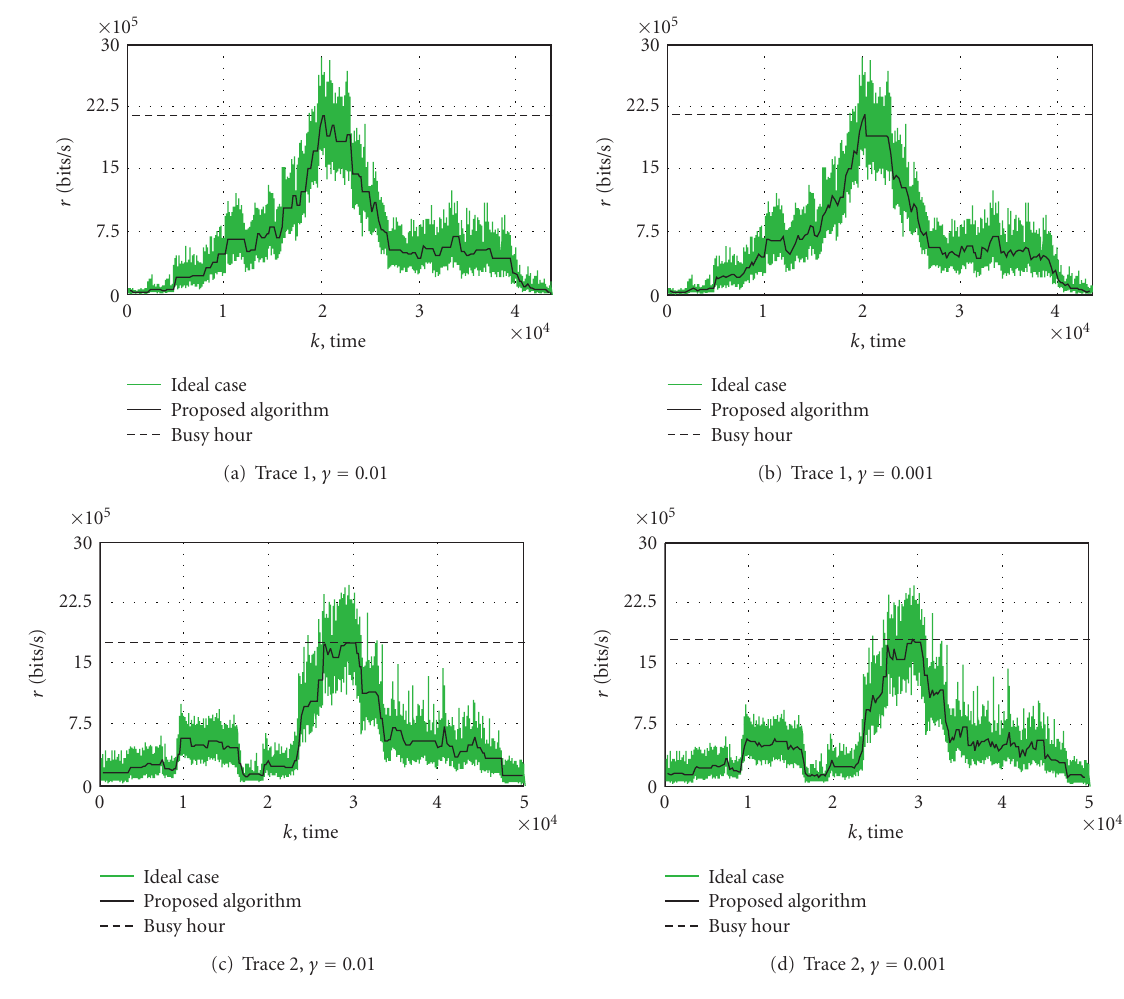
Figure 13: Bandwidth allocations for di ff erent approaches.